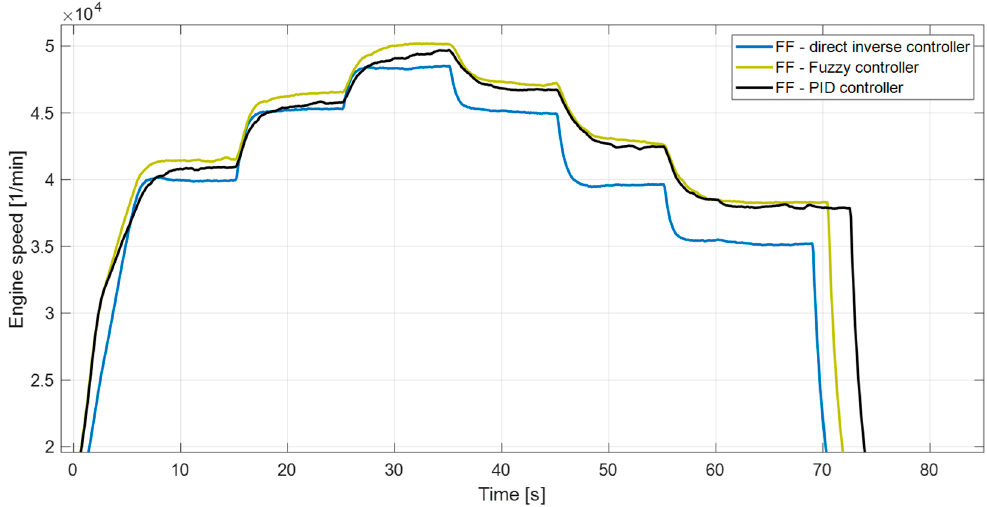
Figure 17. Speed of the iSTC ‐ 21v engine with different fuel flow controllers.